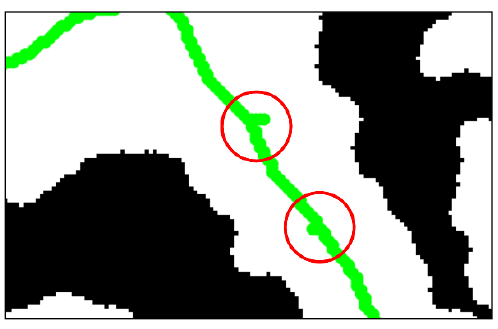
Figure 11. Spurious branches of skeleton.